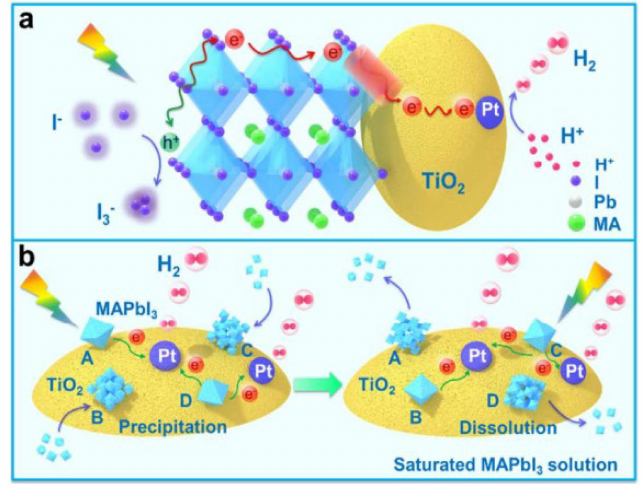
Figure 14. Schematic illustration of the photocatalytic H 2 evolution from HI splitting on Pt/TiO 2 - MAPbI 3 . ( a ) A nanoscale electron transporting channel was established between Pt/TiO 2 and MAPbI 3 . ( b ) The dissolution and re-precipitation of MAPbI 3 in the saturated HI solution formed the dynamic interface between Pt/TiO 2 and MAPbI 3 . Reproduced with permission from [180]. Copyright American Chemical Society,